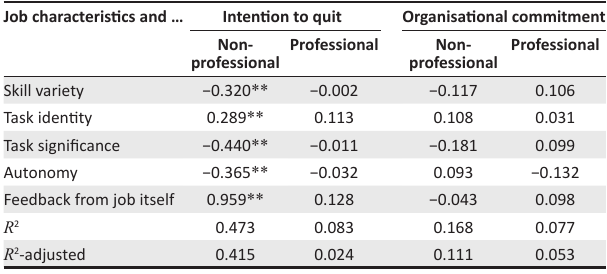
TABLE 1: Correlation between job characteristics and intention to quit and organisational commitment per staff